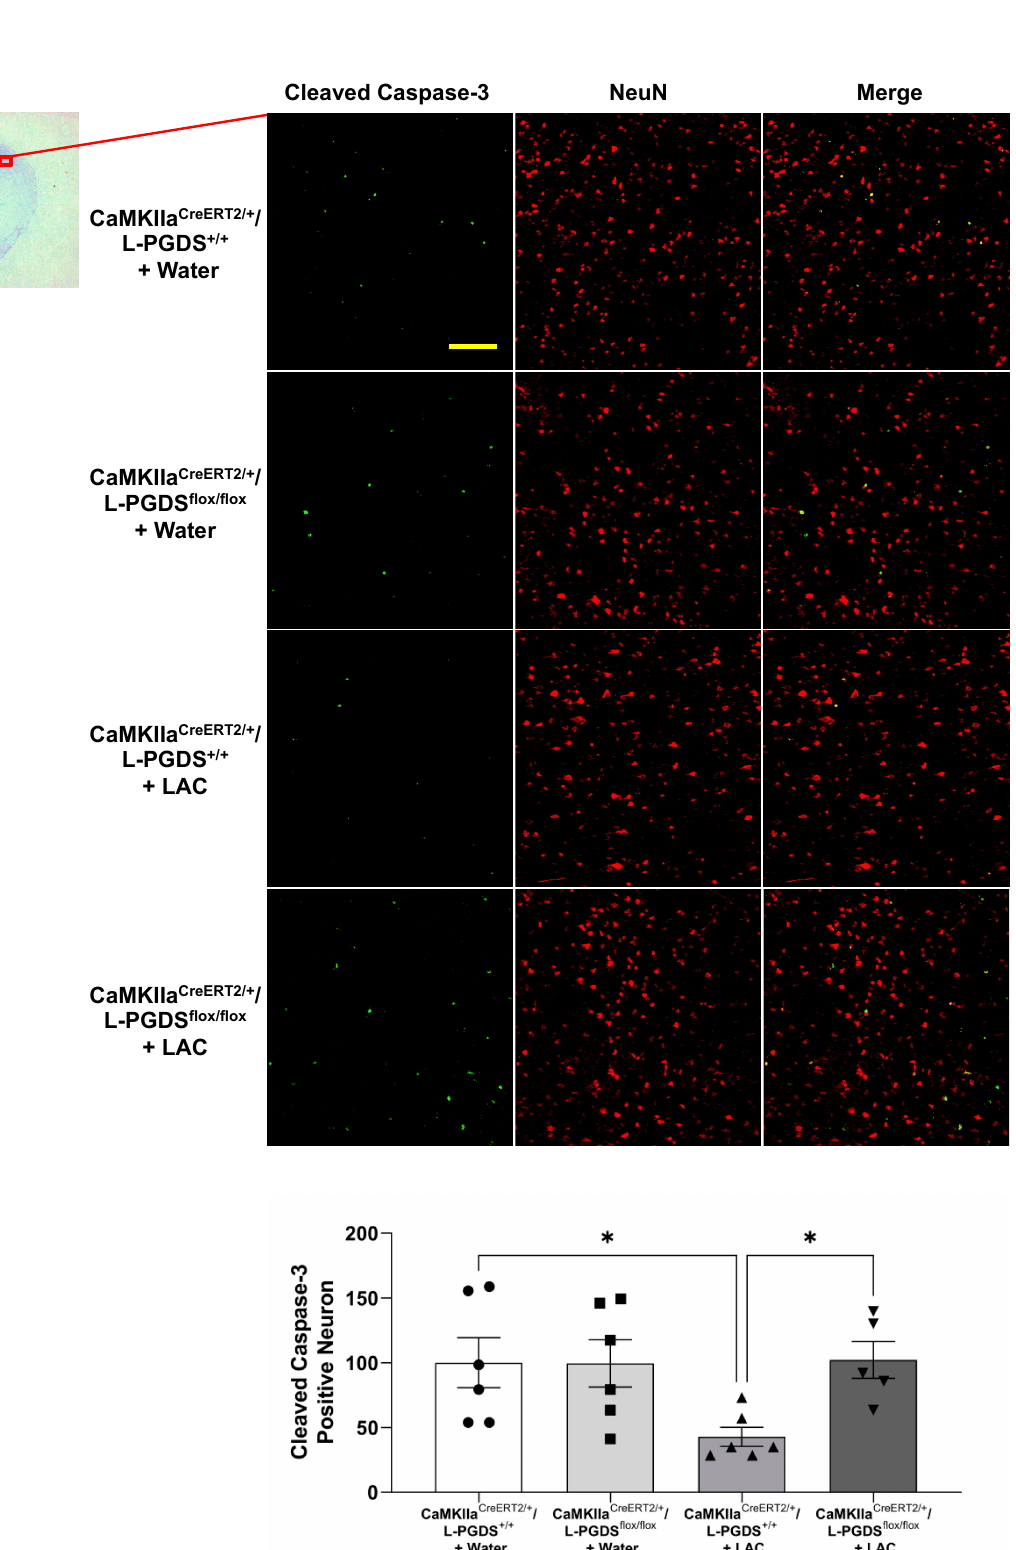
Figure 7. Effect of forebrain neuron-specific L-PGDS knockdown on the cleaved caspase-3-positive neuron in the cerebral cortex following transient focal cerebral ischemia. ( A ) Representative double staining of NeuN and TUNEL in the peri-infarct cortex of the parietal lobe at the section 0.23 mm caudal to bregma. Scale bar = 100 μ m. ( B ) Values of cleaved caspase-3-positive neurons are means ± SEM for 5–6 mice in each group. * p < 0.05. Analyzed using two-way ANOVA followed by Tukey’s test.